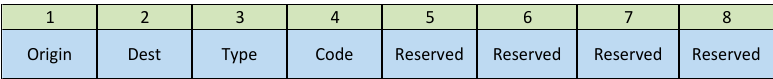
Figure 6. Structure of the TimeStamp message.